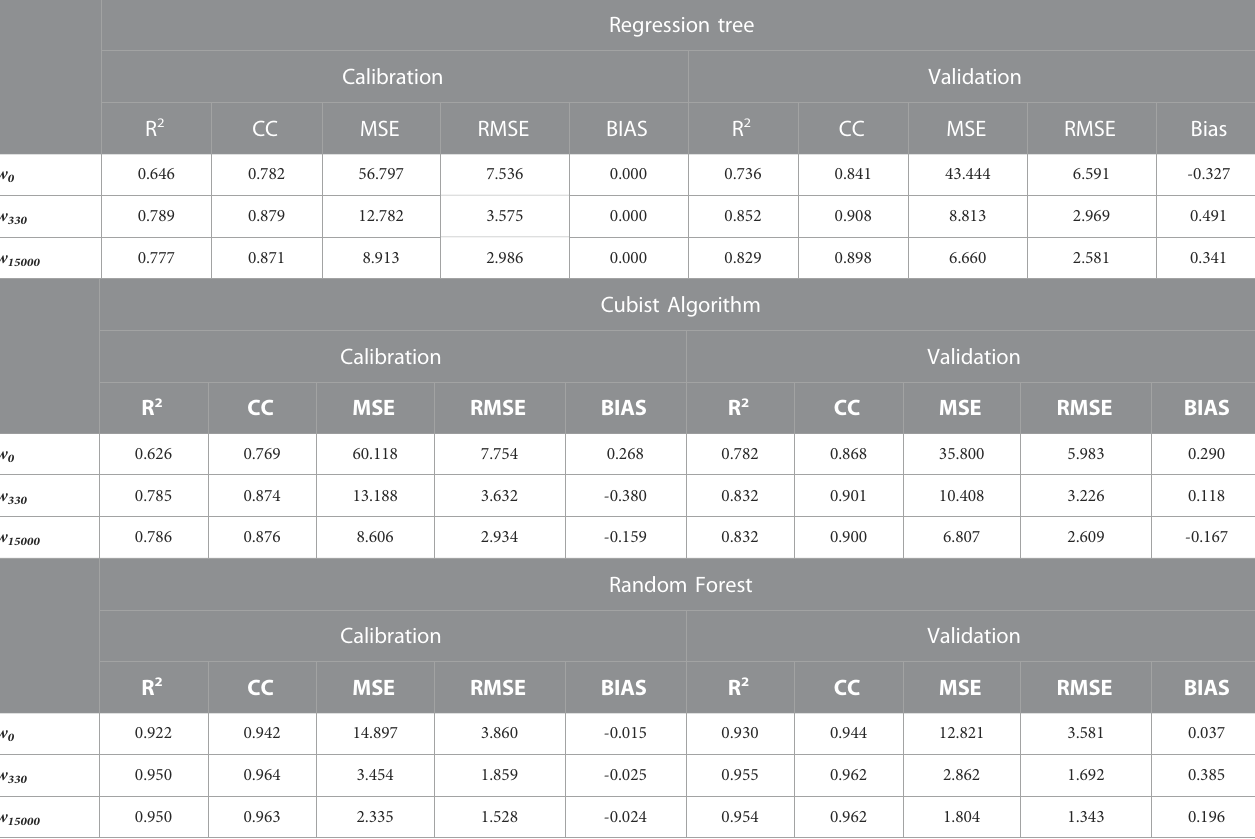
Frontiers in Environmental